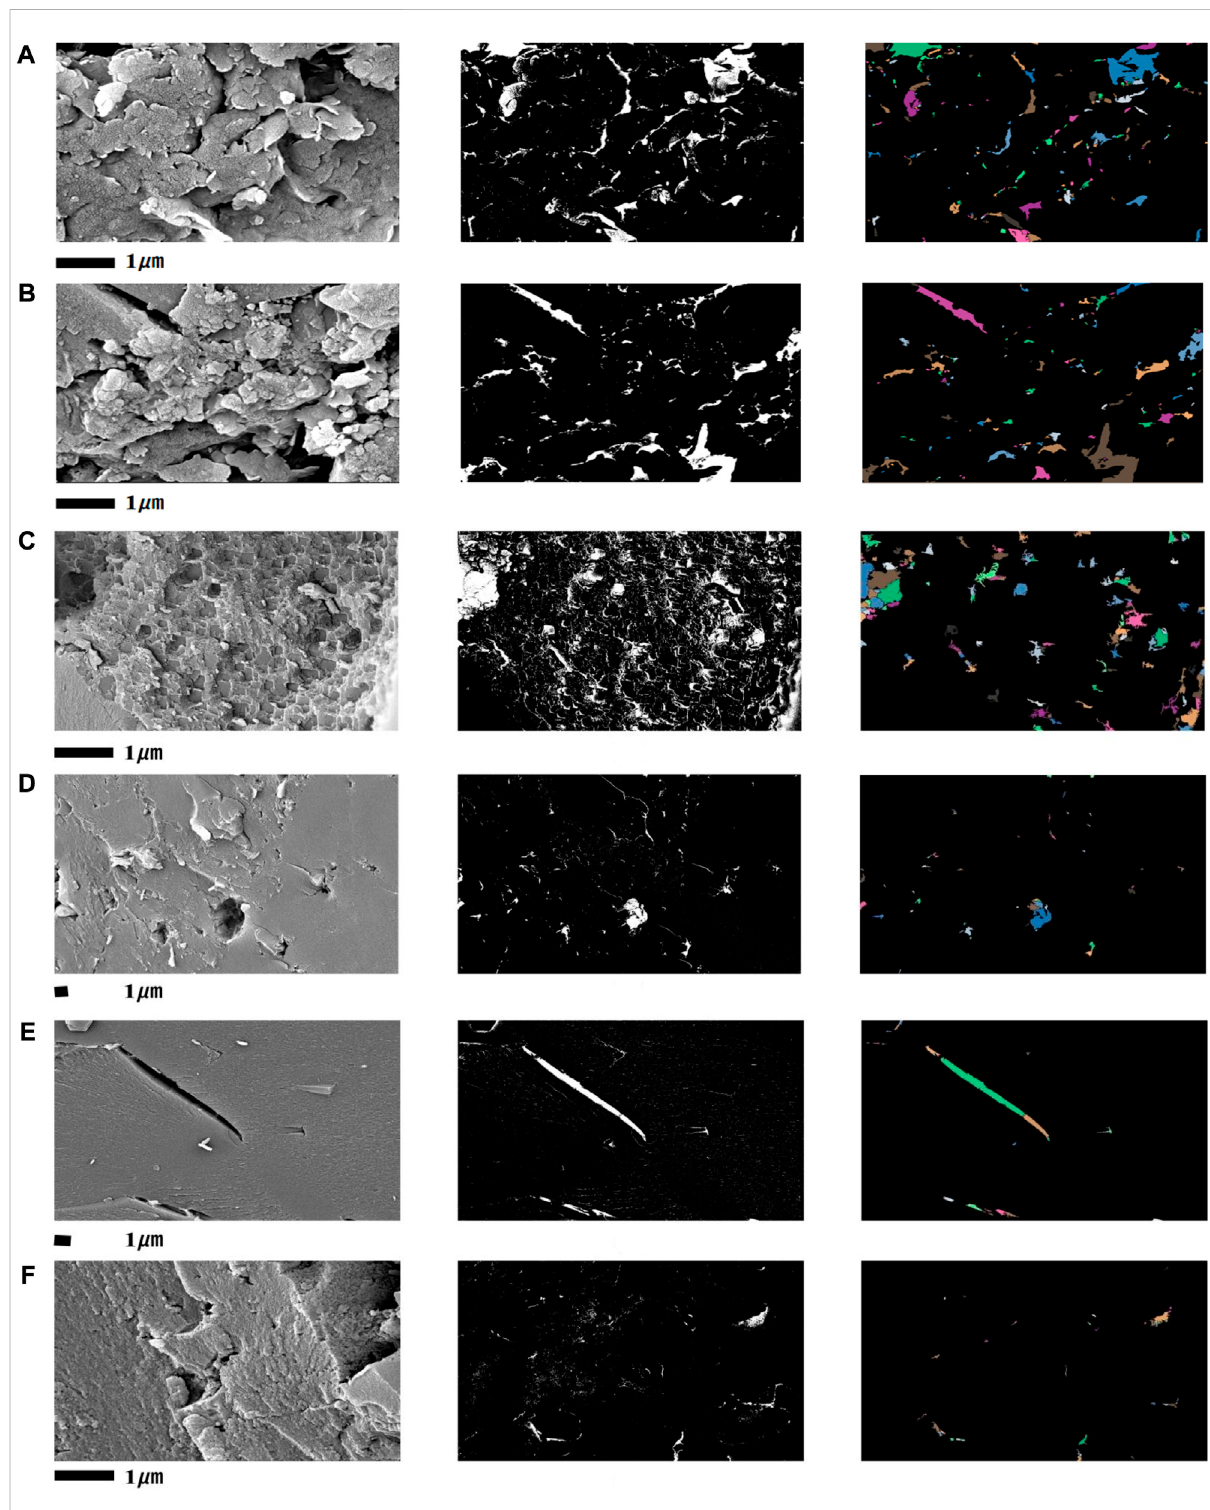
FIGURE 4 SEM and parametric processing of